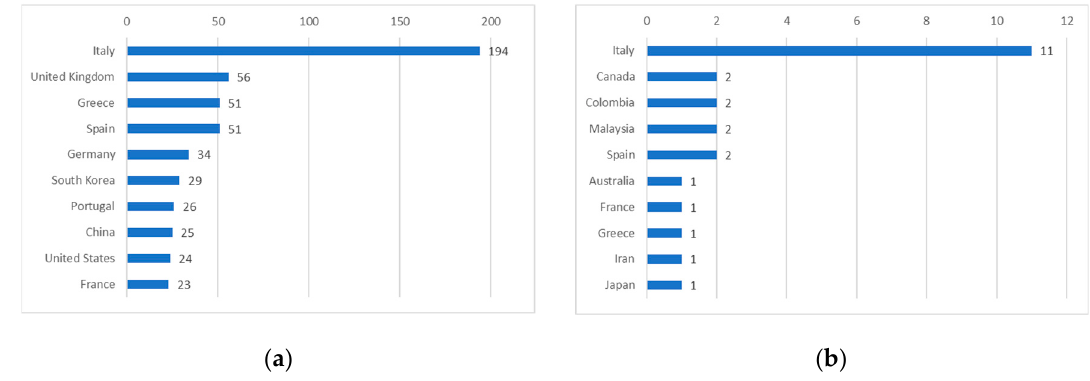
Figure 4. Top ten countries of the authors of the publications relating “augmented reality” with ( a ) “cultural heritage” and ( b ) “architectural heritage”.